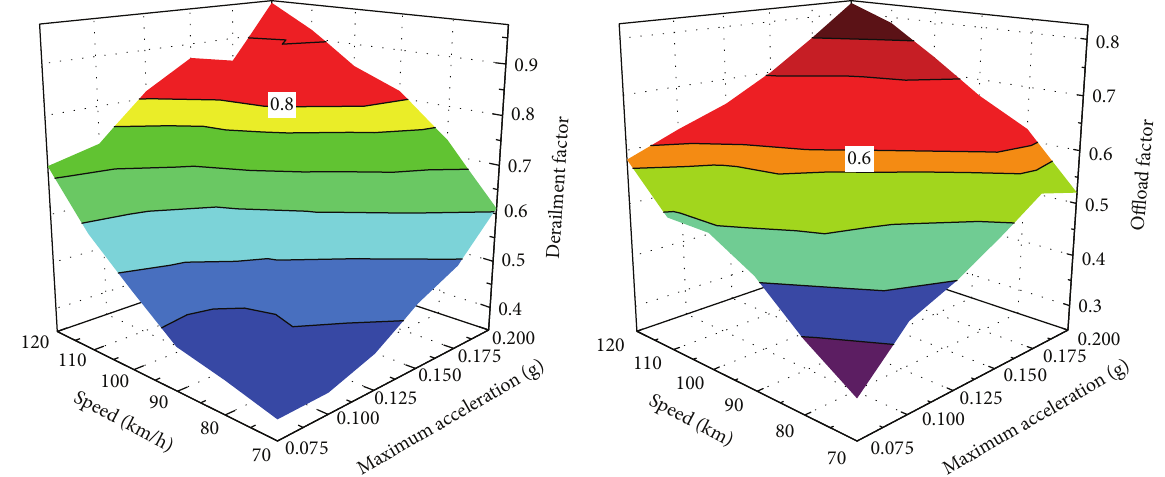
Figure 20: Train speed—maximum acceleration—running safety indices plot.